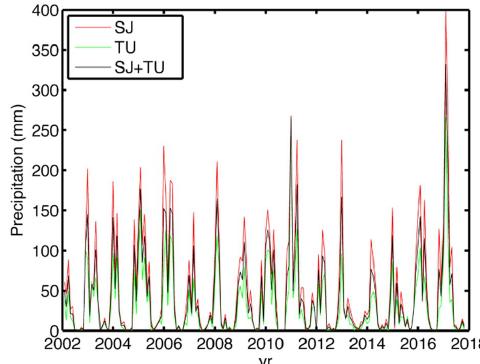
Figure 6. Precipitation records derived from Parameter-Elevation Regressions on Independent Slopes Model (PRISM) for the San Joaquin Valley (SJ) basin and Tulare (TU) basin and a combination of the two, showing seasonal variations. There is much higher precipitation in 2017 due to the second wettest rainy season on